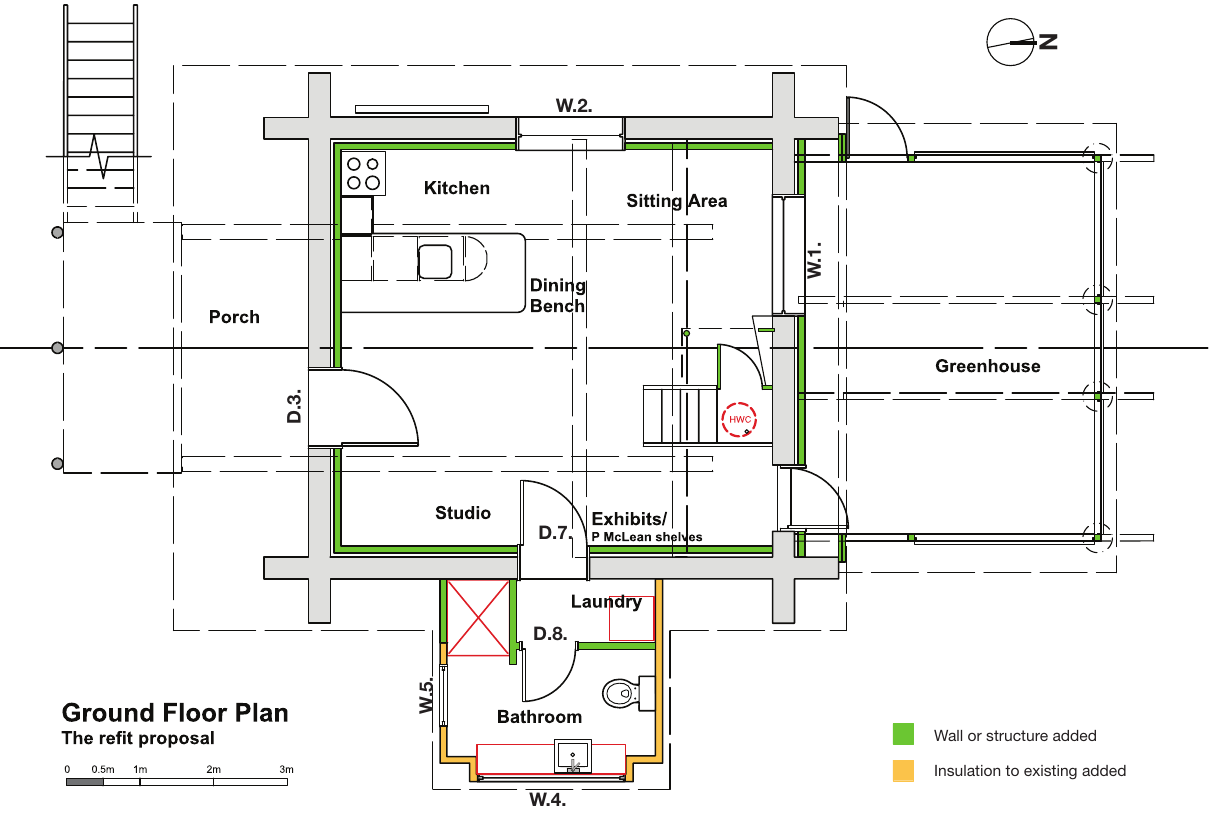
Figure 2. The students’ renovation concept: Ground floor